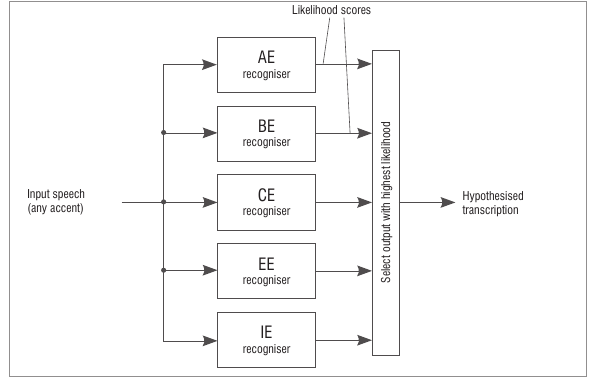
Figure 2: Parallel configuration in which multiple accent-specific recognisers are placed in parallel for simultaneous speech recognition in the five South African English accents: White South African English (EE), Indian South African English (IE), Black South African English (BE), Afrikaans English (AE) and Cape Flats English